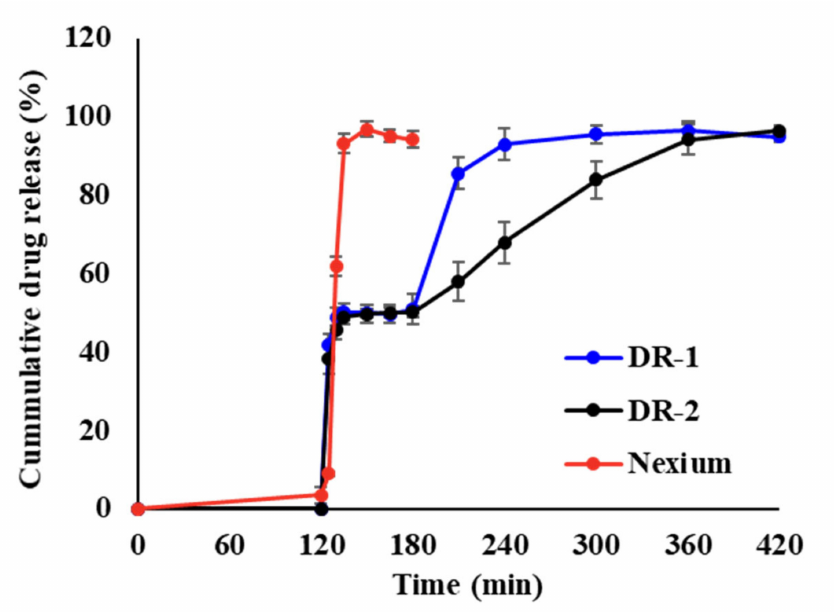
Figure 6. The release profile of DR